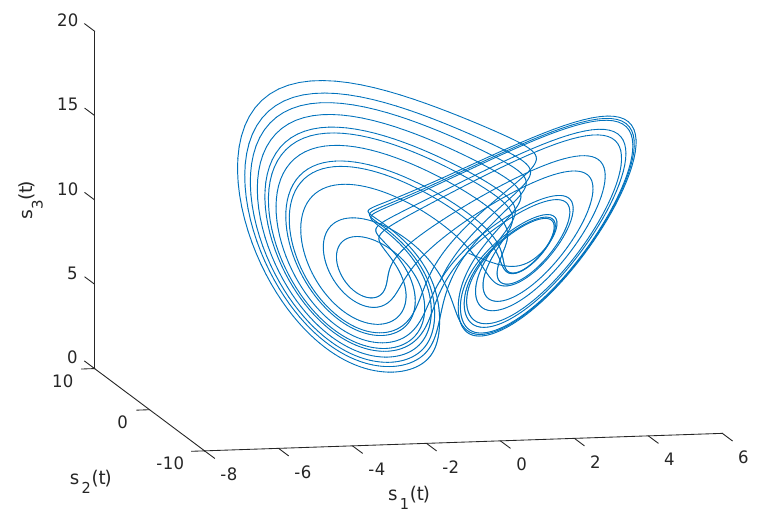
Figure 2. The chaotic behavior of System